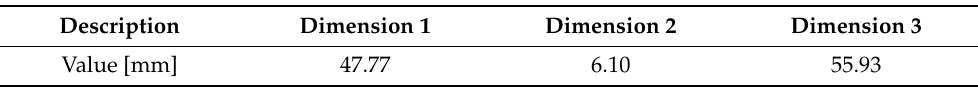
Figure 14. Deflection for the pivot sub-assembly with 0.5% shrinkage-rate constant applied. Table 23. Results of dimension 1, 2, 3 for the pivot sub-assembly with 0.5% shrinkage-rate constant applied.